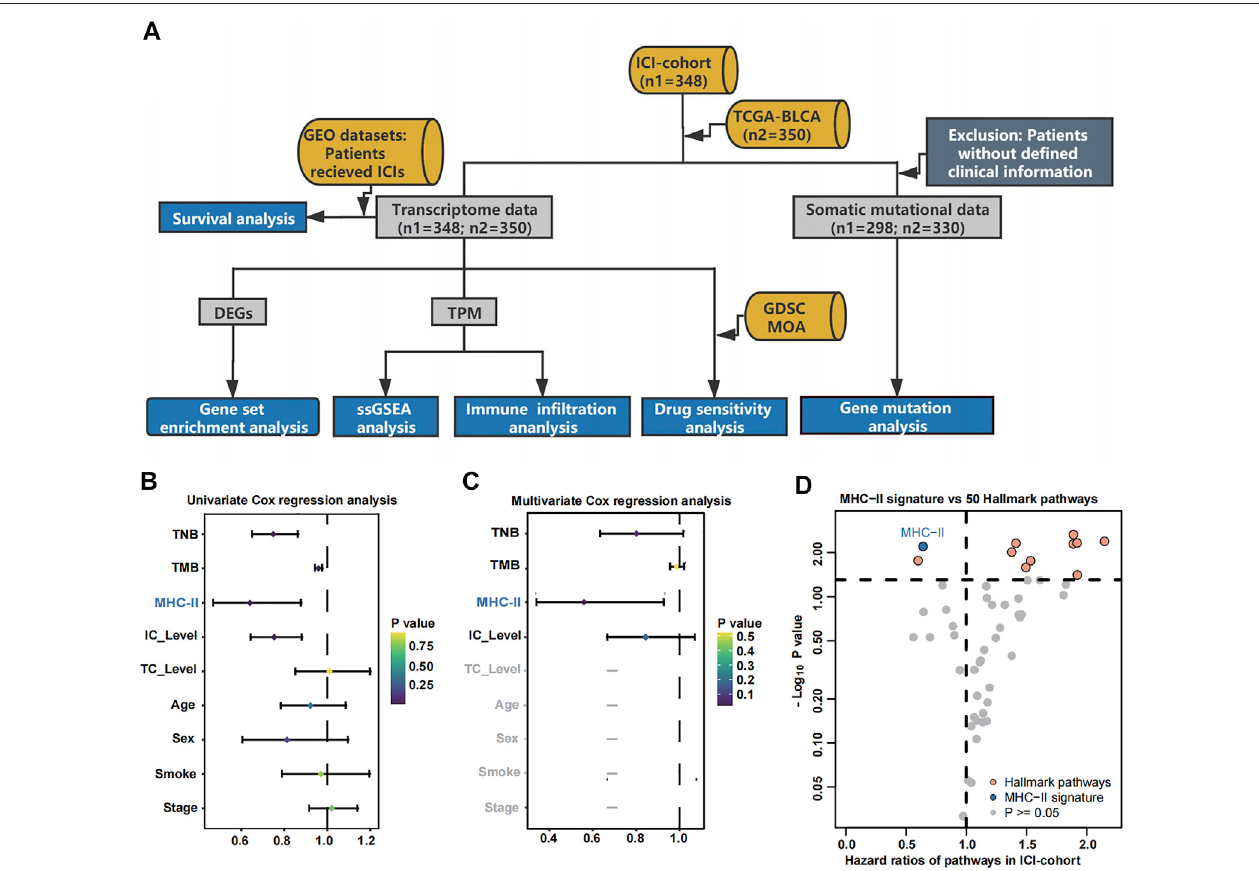
FIGURE 1 | Cox proportional hazards regression analysis results for the ICI-cohort and fl owchart. (A) . Flowchart. We quanti fi ed MHC-II signature by using the ssGSEA method to calculatethe MHC-II signature score, then divided the patients into MHC-H and MHC-L groups within the ICI-cohort ( n = 348) and the TCGA-BLCA cohort ( n = 350). Based on these categories, patients with different MHC-II signature levels were comprehensively analyzed and classi fi ed by their immunome, transcriptome, metabolome, genome and drugome data. We also collected the transcription and survivaldata of twoGEO cohorts treated withimmunotherapy to verify thepredictive value oftheMHC-II signature. MHC-H:MHC-II signature score high; MHC-L: MHC-II signature score low. (B) The forest plotdisplays theresults ofa univariate analysis. Variables with a Cox P value less than 0.05 are MHC-II, TMB, TNB and IC Level. MHC-II: MHC-II signature score. The signature scores of the gene sets were calculated using the ssGSEA algorithm. (C) The forest plot displays the results of a multivariate analysis. Only MHC-II signature was an independent and favorable predictor of bladder cancer patients treated with ICIs (P < 0.05). (D) The volcano plot displays the results of a univariate analysis between MHC-II signature score (blue) and 50 hallmark pathways scores (orange and gray). Gray dots indicate pathways with a Cox P value less than 0.05. The hazard ratio [HR] indicates protective(HR < 1)orrisk(HR > 1)factors.Thehorizontaldashedlineindicates p =0.05.Thegenesetsof50hallmarkpathwayswereobtainedfromtheMSigDB.Orange dots from left to right indicate the following pathways: spermatogenesis, angiogenesis, coagulation, UV response DN, xenobiotic metabolism, TGF β signaling, hypoxia, wnt β catenin signaling, reactive oxygen species pathway and p53 pathway.